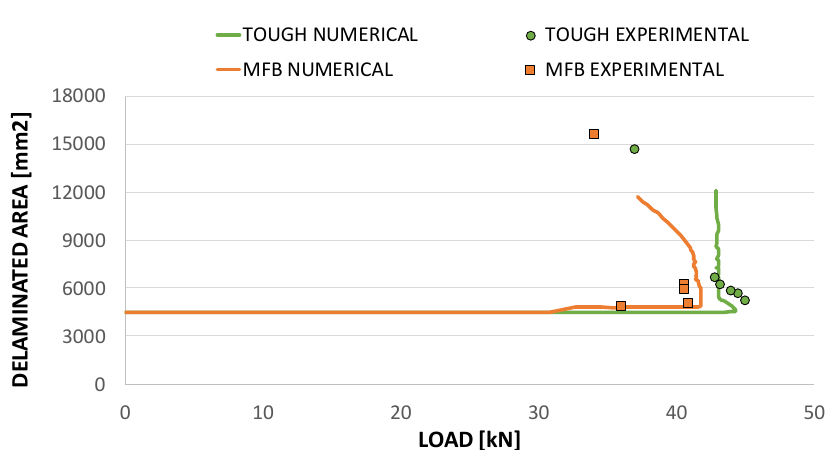
Figure 19. Delaminated area as a function of the compressive load: comparison between experimental data and numerical results.